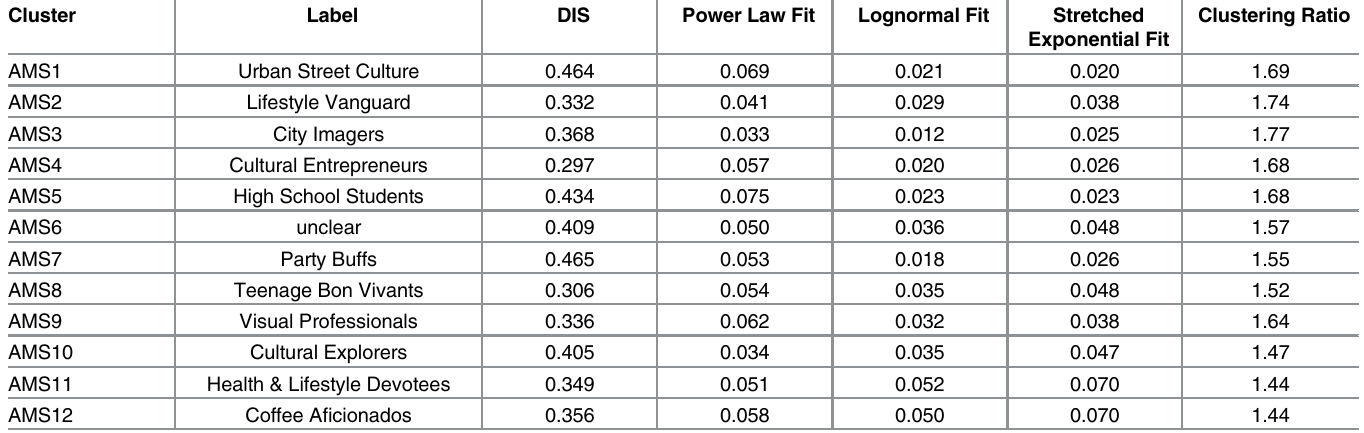
Table 3. Additional data on Amsterdam clusters.